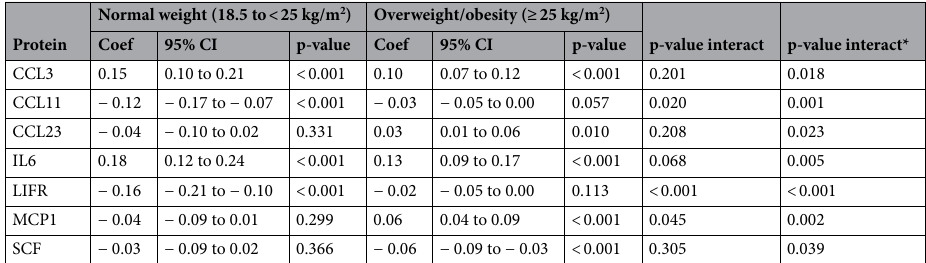
Table 5. Association between visceral fat rating and protein levels stratified by BMI categories. Stratified analyses in BMI categories from linear regression of transformed protein levels adjusted for sex, smoking, e-cigarette use, snuff use, and age at follow-up. The table includes all proteins with unadjusted p-value for the interaction term VFR#BMI_category of < 0.05. p-values at 0.05 FDR. *p-value for the interaction term without FDR